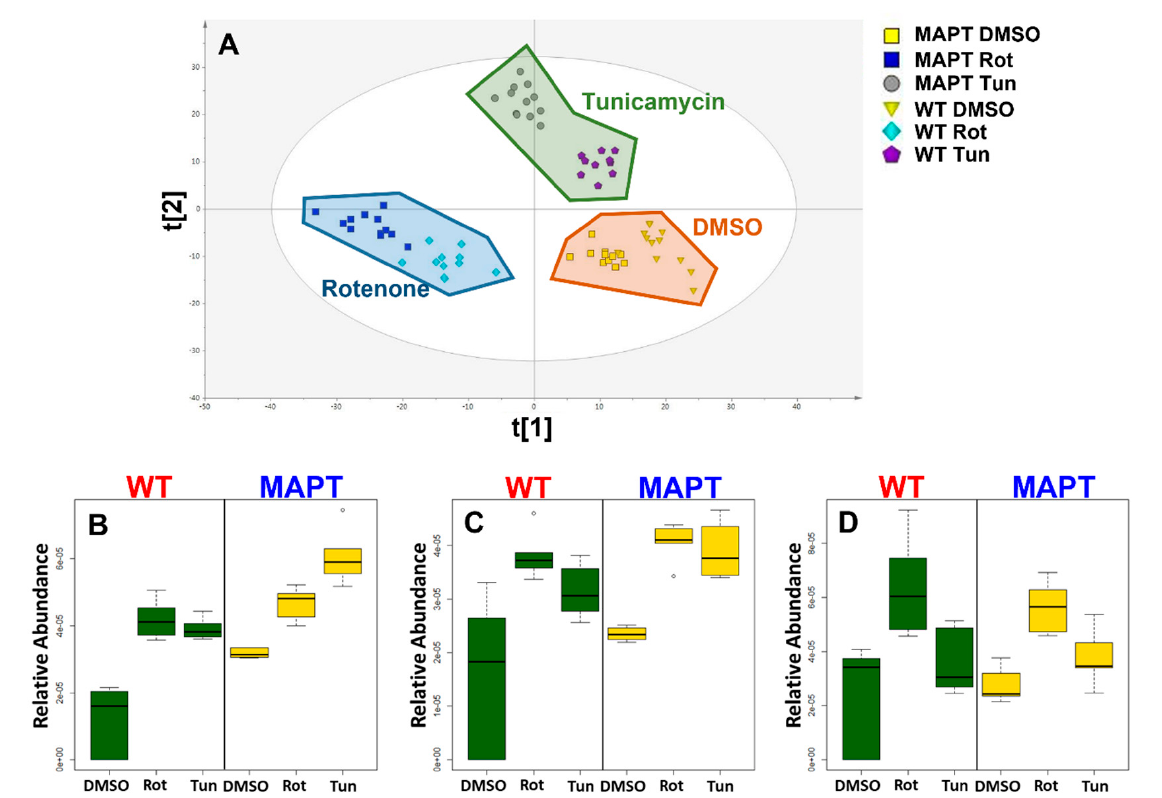
Figure 2. Multivariate and univariate analysis of triglycerides in response to Rotenone and Tuni- camycin in both wild type and MAPT mutant dopamine neurons. ( A ) PLS − DA scores plot calculate from triglyceride data for all groups (t[1] = 31.1% and t[2] = 11.1%) ( B ) boxplot of TG(54:2), ( C ) boxplot of TG(58:3), ( D ) boxplot of TG(58:5). Abbreviations: MAPT; microtubule associated protein tau, Rot; rotenone, TG; triglyceride, Tun; tunicamycin, WT; wild type.